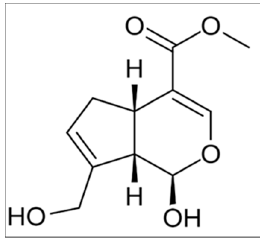
Figure 1. Genipin. Figure 1.